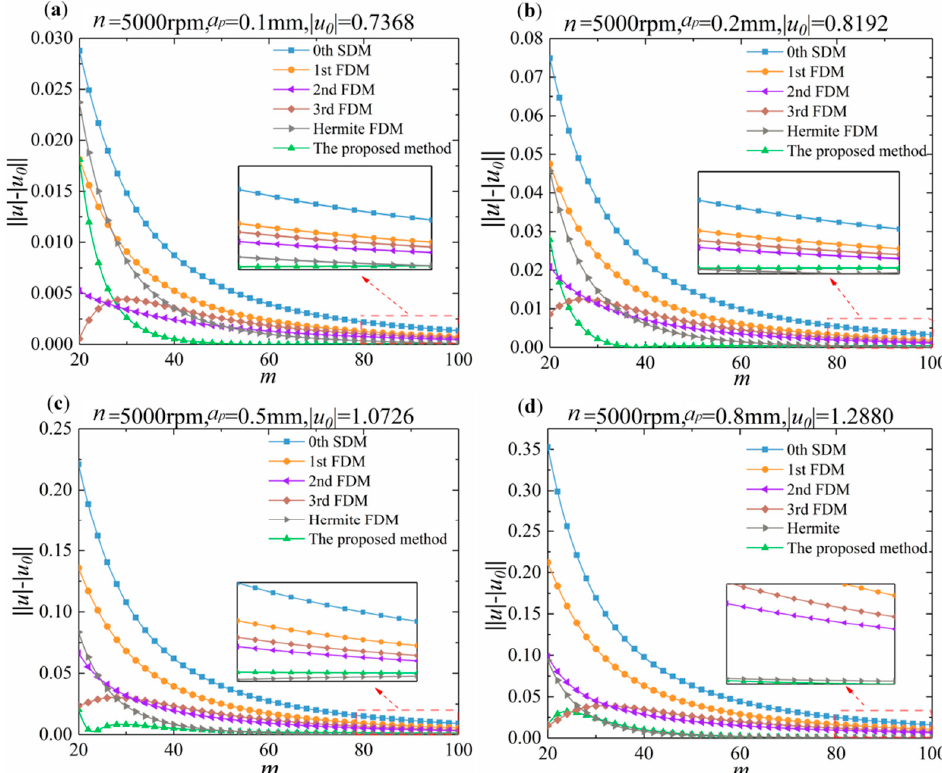
Figure 2. The convergence rate of eigenvalues for different discrete numbers m for the 0th SDM, 1st FDM, 2nd FDM, 3rd FDM, Hermite FDM, and the proposed method. ( a ) Axial depth of cut a p is 0.1 mm, exact eigenvalue | 𝜇 0 | is 0.7368. ( b ) Axial depth of cut a p is 0.2 mm, exact eigenvalue | 𝜇 0 | is 0.8192. ( c ) Axial depth of cut a p is 0.5 mm, exact eigenvalue | 𝜇 0 | is 1.0726. ( d ) Axial depth of cut a p is 0.8 mm, exact eigenvalue | 𝜇 0 | is 1.2880.